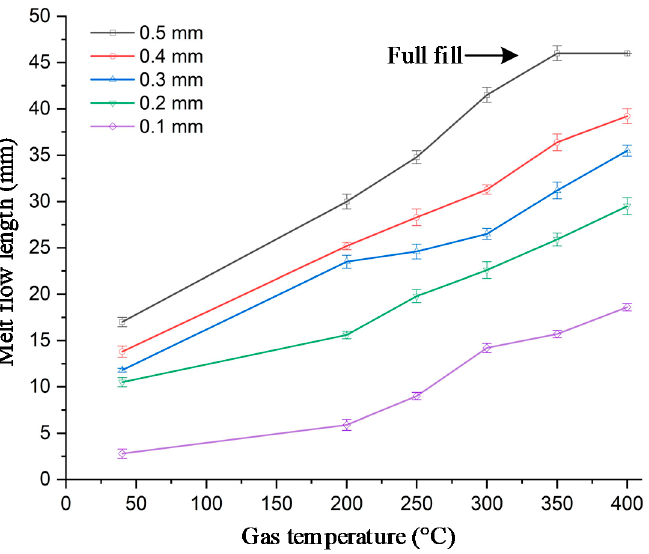
Figure 15. The melt flow length and gate temperature under different gas temperatures for In- GMTC.